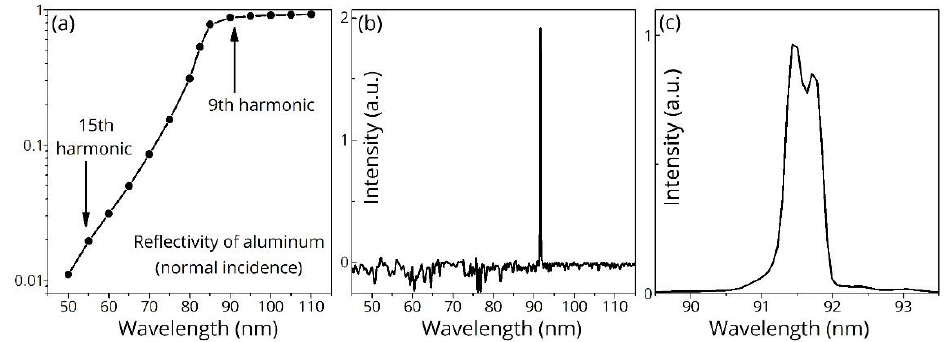
Figure 3. ( a ) Normal-incidence reflectivity of aluminum. ( b ) Spectrum of the 9th harmonic after a couple of bounces by bare aluminum mirrors. ( c ) Spectral shape of the 9th harmonic.